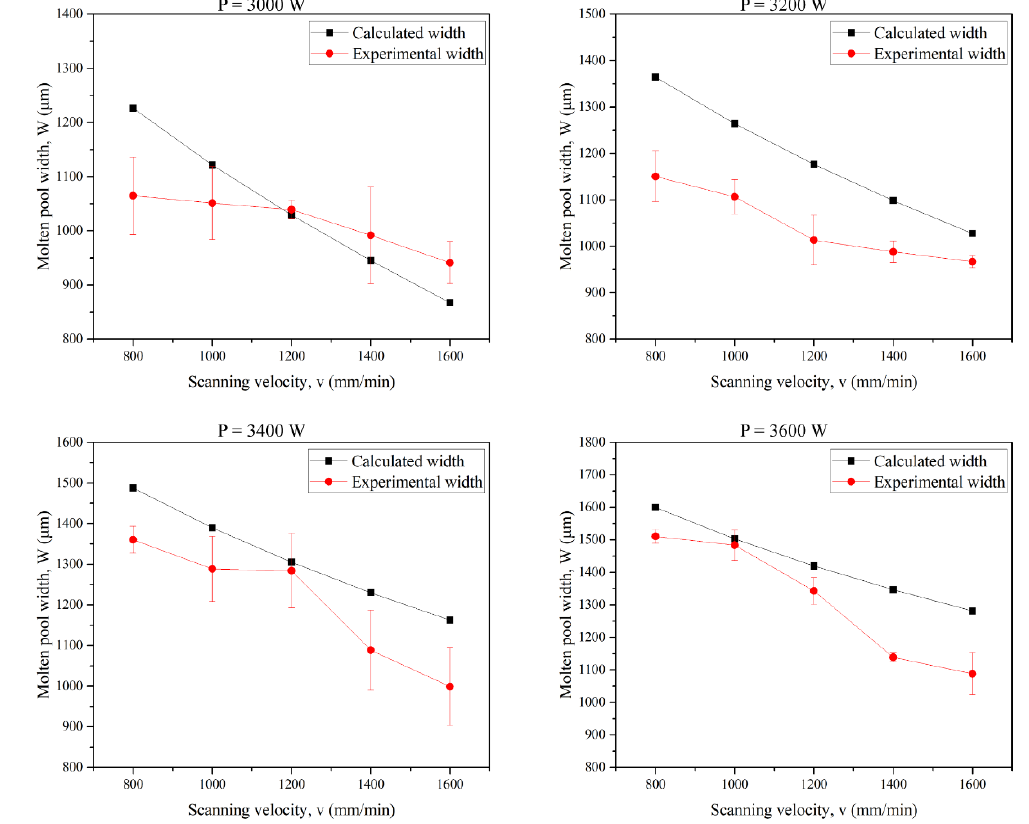
Figure 11. Comparison of experiment and calculated values of the single-track molten pool width.